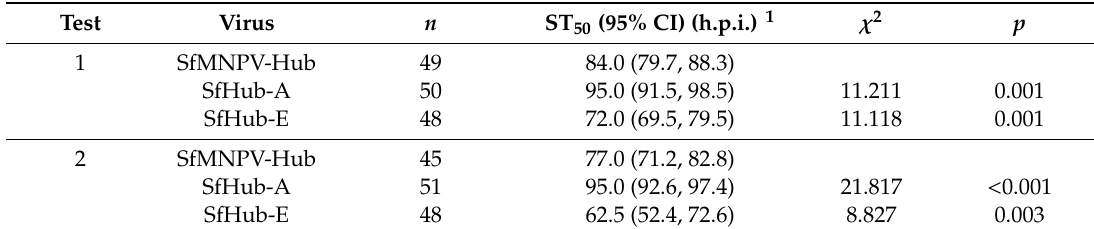
Table 2. Median survival times (ST 50 ) of the second-instar S. frugiperda larvae inoculated with the SfMNPV field isolate and